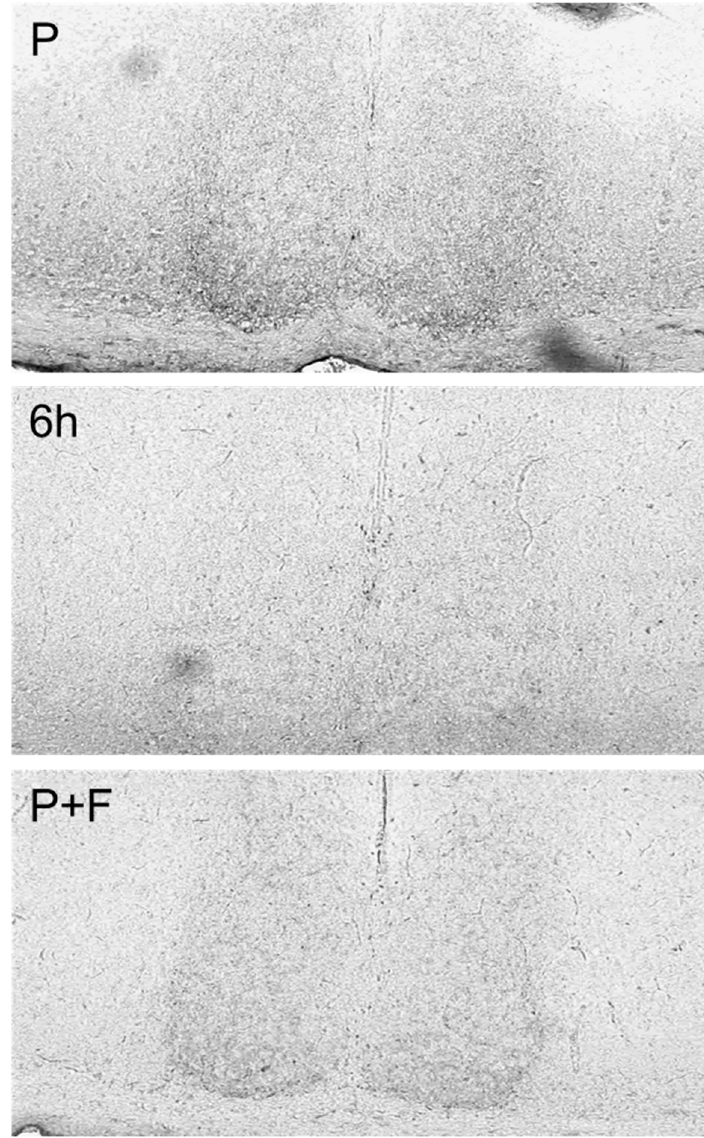
Figure A4. Vasoactive-intestinal peptide immunoreactivity in the suprachiasmatic nuclei of Syrian hamsters. Comparison between sexual stimulation with pheromone (P, group 2), 6 h manual sleep deprivation (6 h, group 3b), and sexual stimulation with pheromone and females (P+F, group 1). Magnification: 50×.